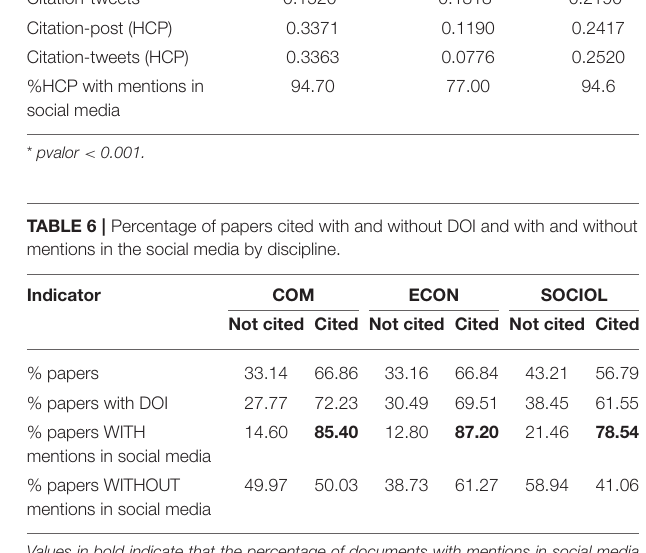
FIGURE 5 | Papers with DOI and mentions in the social media by discipline.